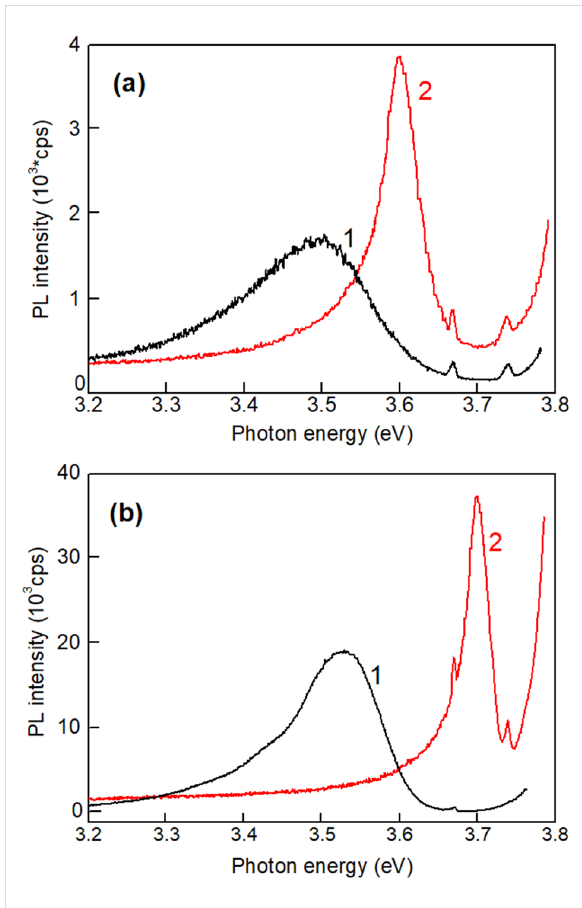
Figure 8: PL spectra of Zn 0.85 Mg 0.15 O films by spin coating (curve 1) and aerosol spray pyrolysis (curve 2) measured a) at room tempera- ture and b) at 20 K with a linear intensity